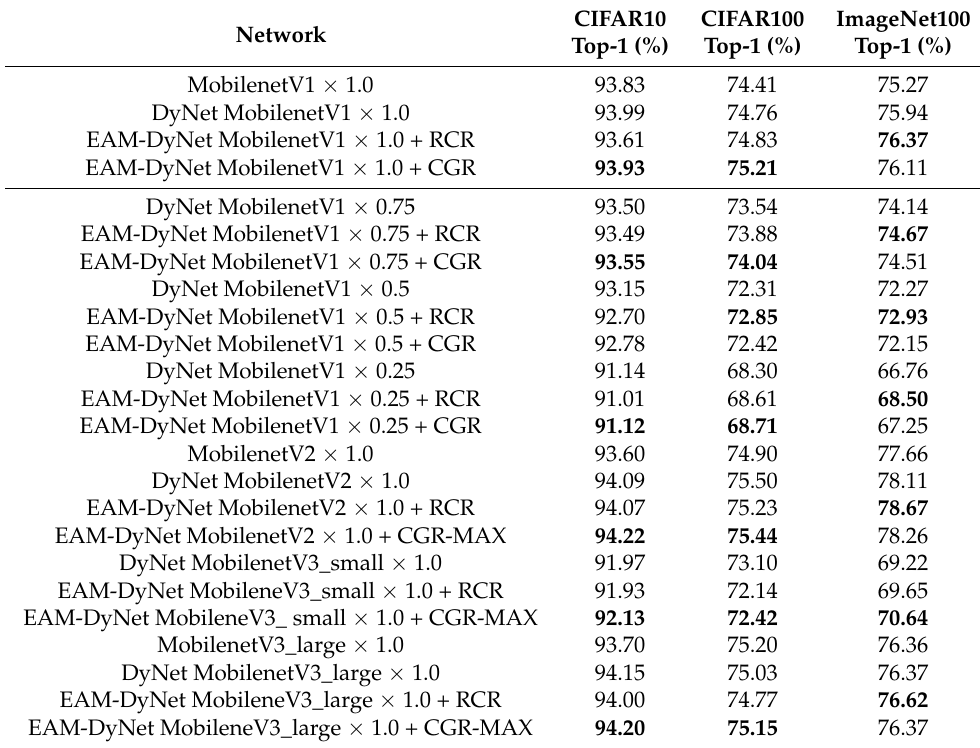
Table 1. The accuracy of different architectures on CIFAR10, CIFAR100, and ImageNet100. Network